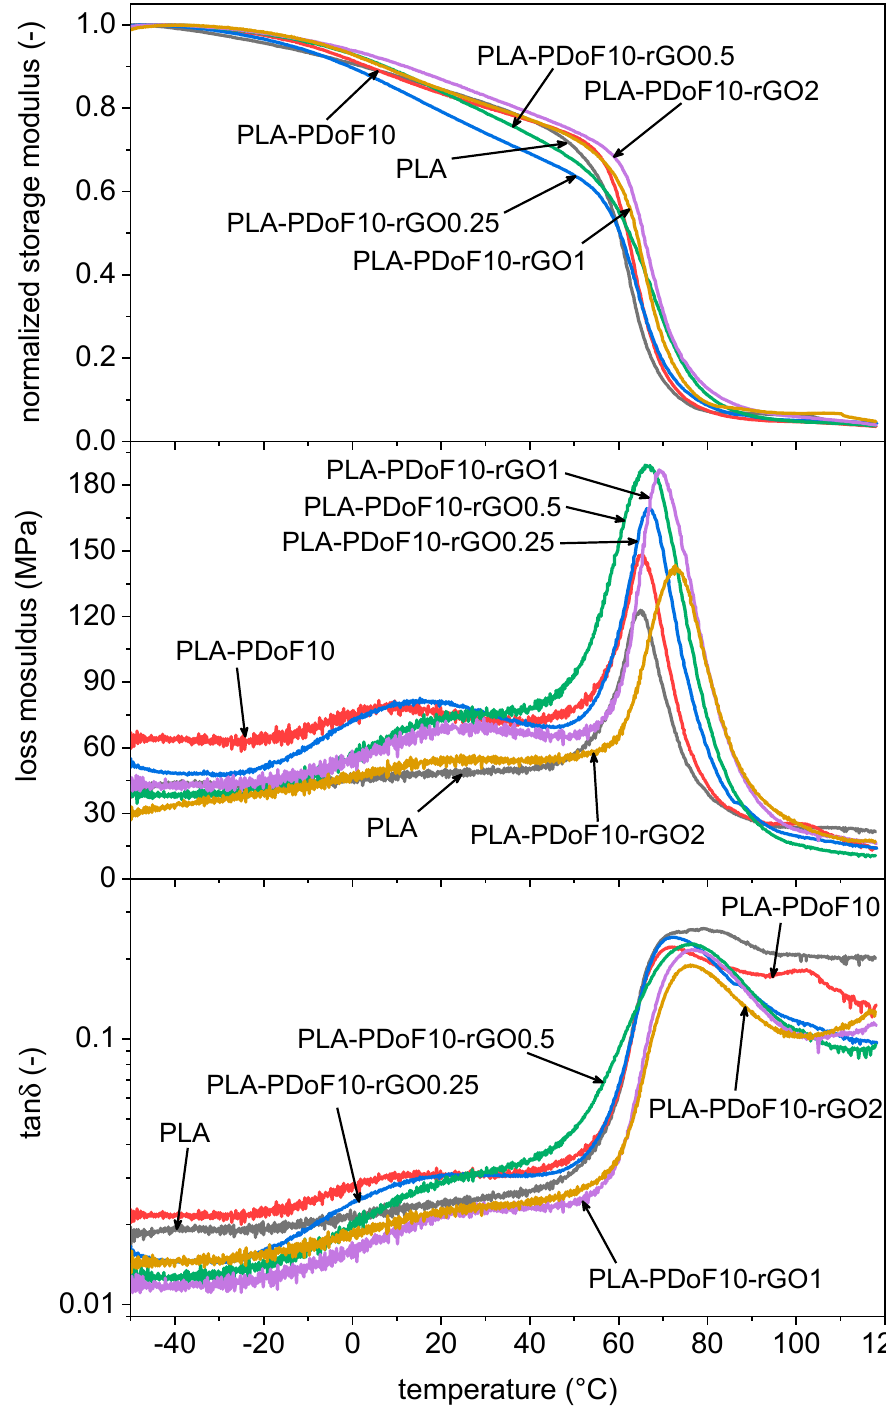
Figure 7. DMTA thermograms of the samples PLA, PLA-PDoF10 and PLA-PDoF10-rGOx (x = 0.25 ÷ 2 phr). Normalized storage modulus ( 𝐸’ ), loss modulus ( 𝐸’’ ) and tan δ as a function of temperature.